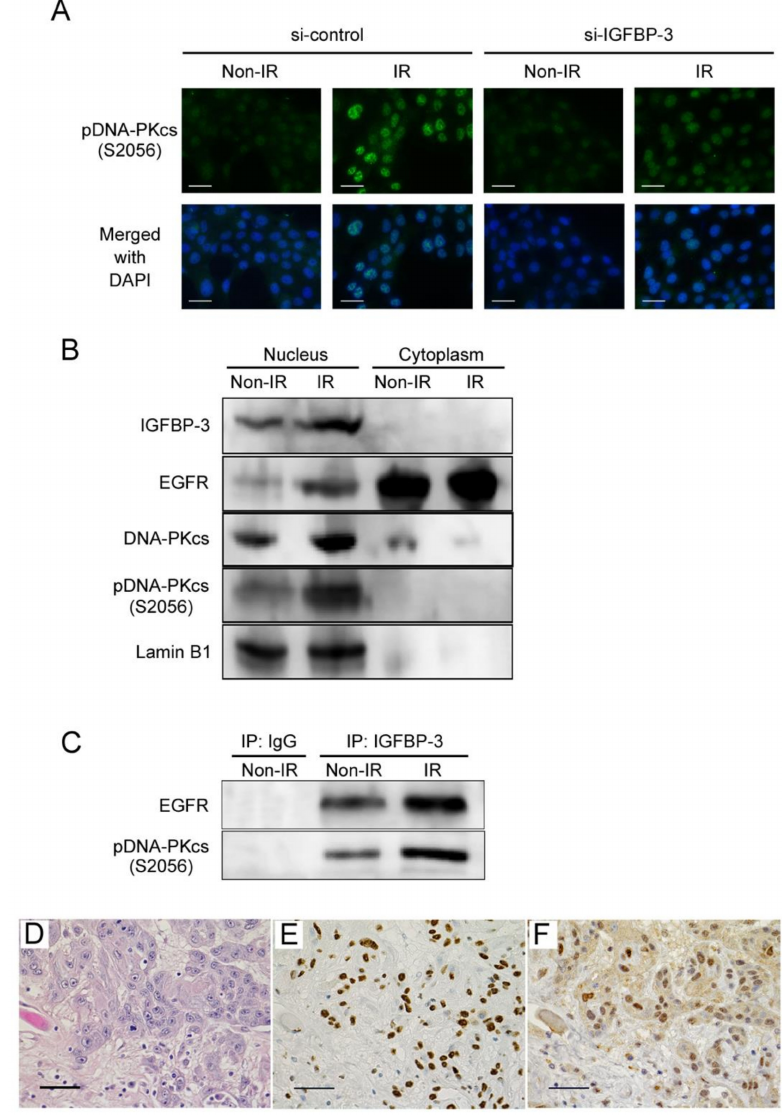
Figure 4. IGFBP-3 is involved in DNA-dependent protein kinase catalytic subunit (DNA-PKcs) activation by interacting directly with DNA-PKcs and epidermal growth factor receptor (EGFR) in irradiated OSCC cells. ( A ) Immunofluorescence for phospho-DNA-PKcs (S2056) in SAS cells 0.5 h after 0 or 10 Gy irradiation with or without IGFBP-3 knockdown. Scale bar, 50 µ m. ( B ) Western blots of IGFBP-3, EGFR, DNA-PKcs, and phospho-DNA-PKcs protein levels in SAS cells at 0.5 h after 0 or 10 Gy irradiation. ( C ) IGFBP-3 / EGFR and IGFBP-3 / phospho-DNA-PKcs complex formation in SAS cells, as detected by immunoprecipitation (IP) assays. An anti-IGFBP-3 antibody was used to immunoprecipitate cell lysates, after which immunoprecipitates were subjected to immunoblotting with anti-EGFR and anti-phospho-DNA-PKcs antibodies. ( D – F ) Representative microscopic images of haematoxylin and eosin ( D ) and immunohistochemical staining for IGFBP-3 ( E ) and DNA-PKcs ( F ) in tumour tissues after chemoradiotherapy. Scale bar, 100 µ